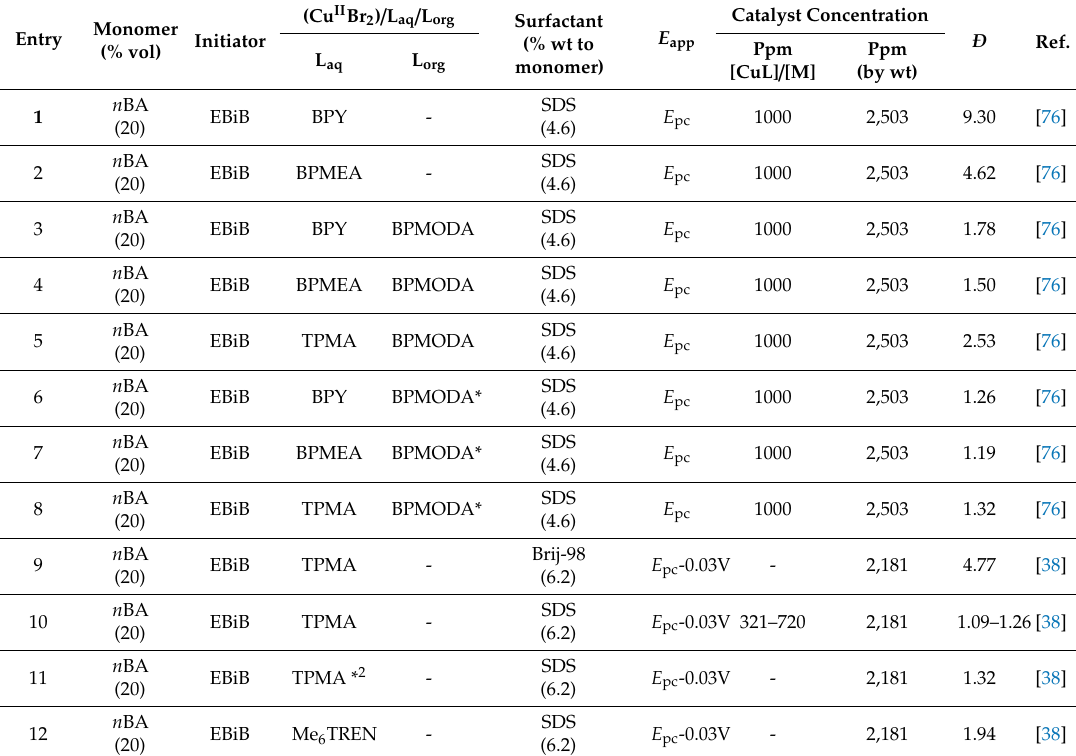
Table 1. e ATRP of n BA in miniemulsion with different surfactants and catalysts a .